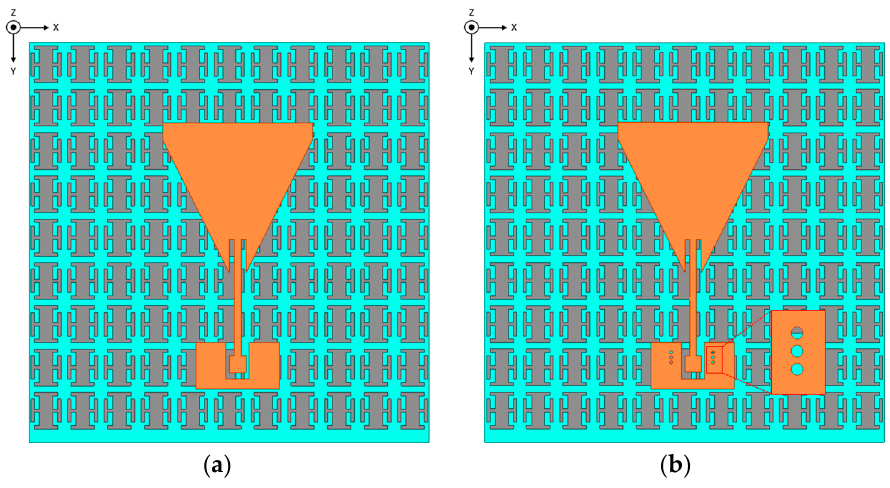
Figure 17. The geometry of the proposed antenna-on-chip: ( a ) Design no holes in the GSG grounding area; ( b ) Design holes in the GSG grounding area.